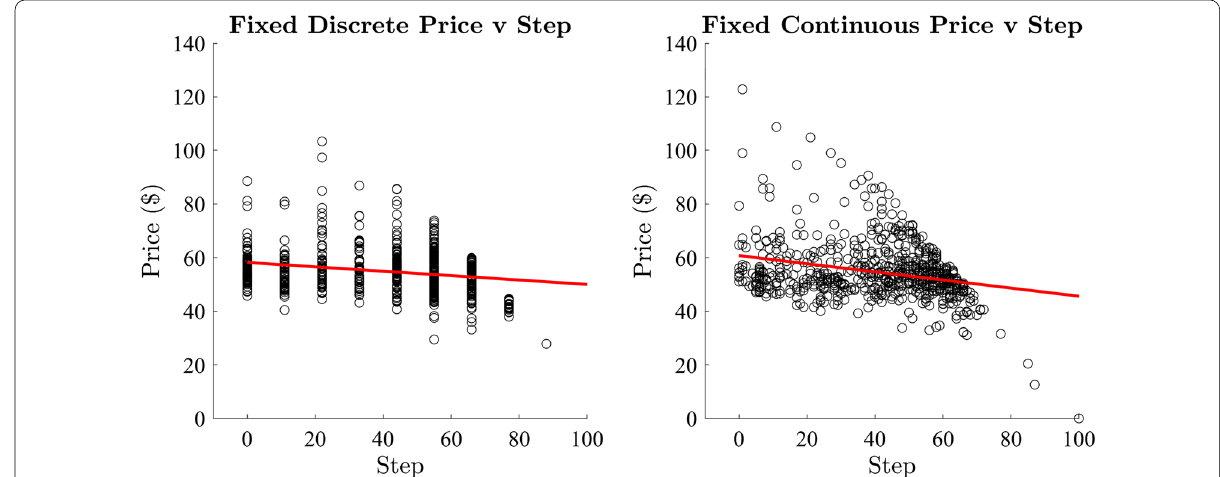
Fig. 4 Exp 1: price and step